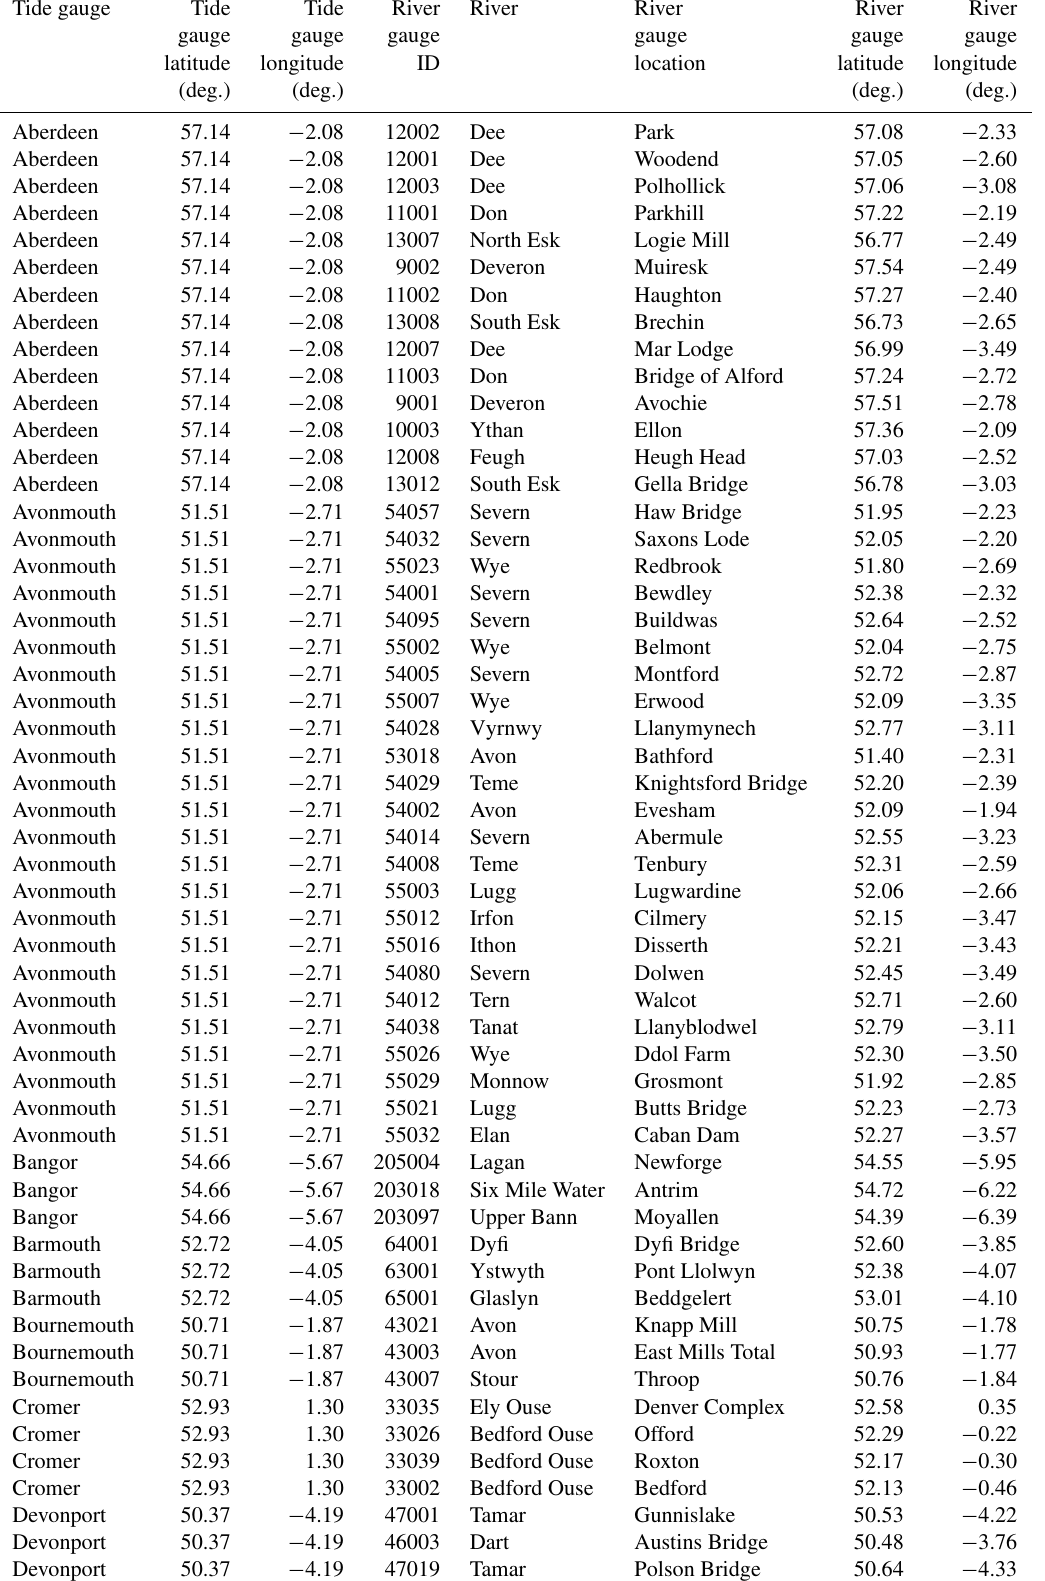
Table 1. The pairs of tide gauge sites and river discharge stations used in the study. Tide gauge Tide Tide River River River River River gauge gauge